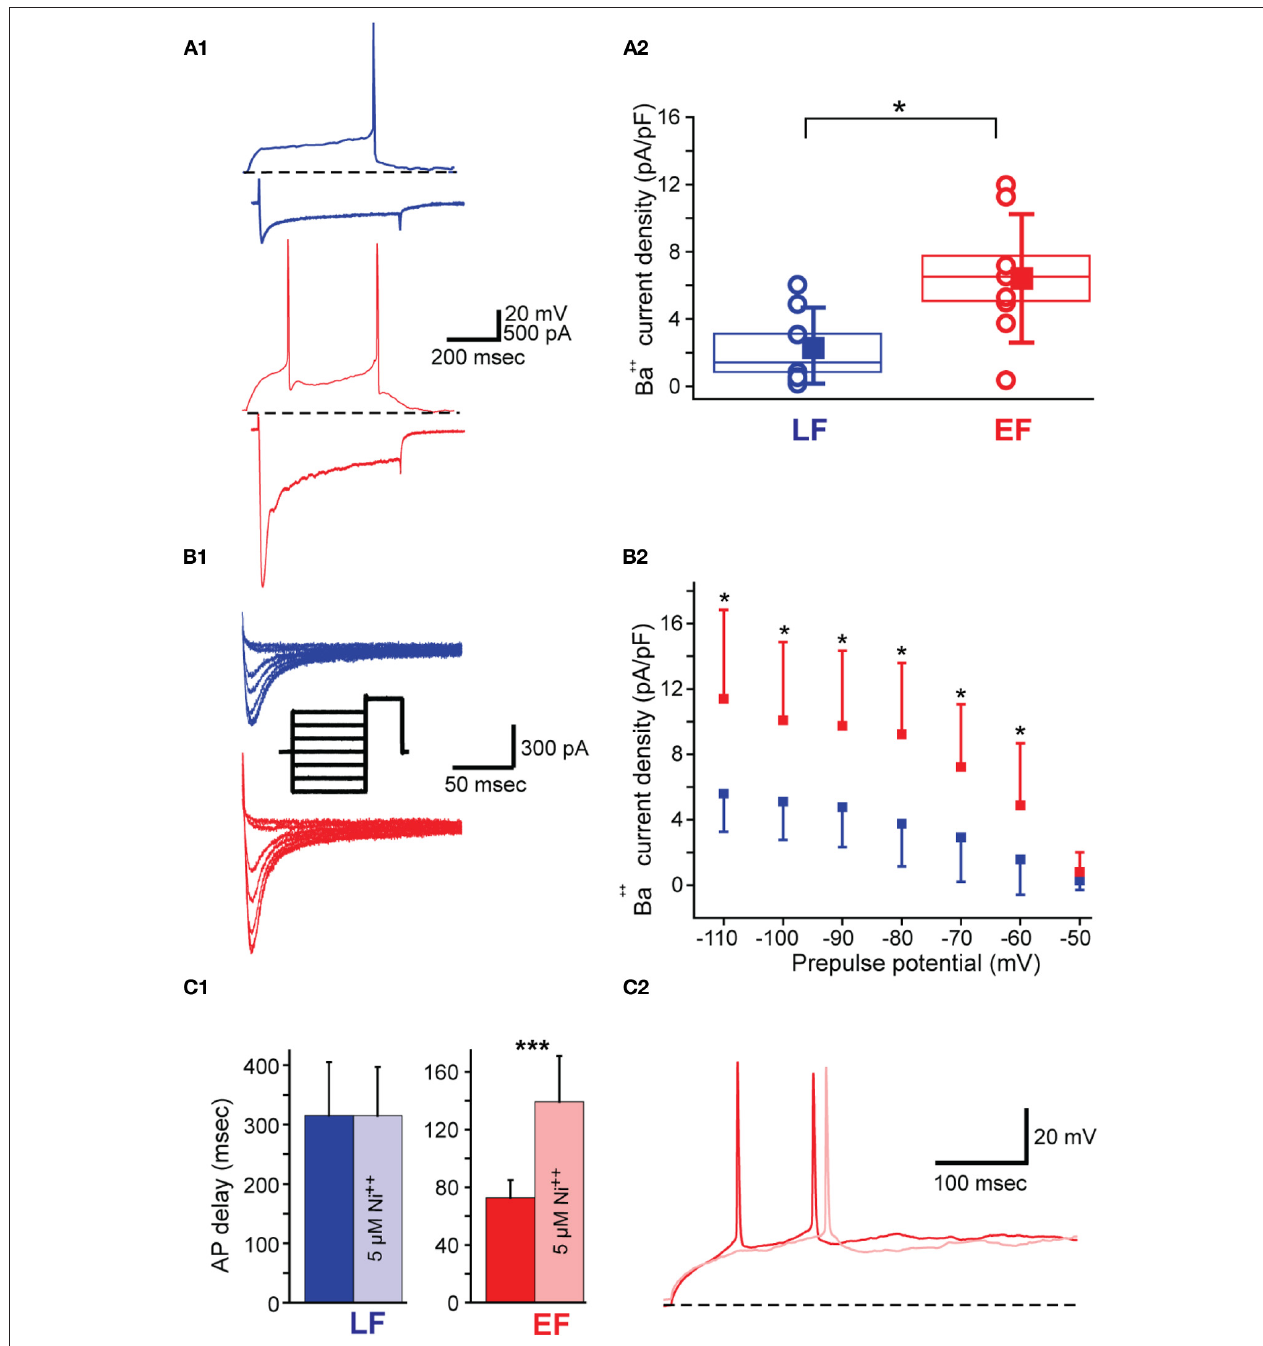
FIGURE 7 | Low voltage activated calcium current (I LVA ) properties in BF neurons. (A1) LF neuron (top blue traces) and EF neuron (bottom red traces) in current clamp (top trace in each case) showing the characteristic AP delay in response to a rheobase current injection (60pA in this case). Bottom trace in each case shows I LVA in response to a voltage clamp step from − 70mV to − 40mV upon re-patching the same cells with Cs-Meth intracellular solution and in Ba 2 + -containing ACSF (see Materials and Methods). Scale bars apply to both neurons. (A2) Box plot for I LVA densities measured as described in A1 . Box size indicates standard error of the mean. Square and whiskers have been displaced for clarity and indicate mean and